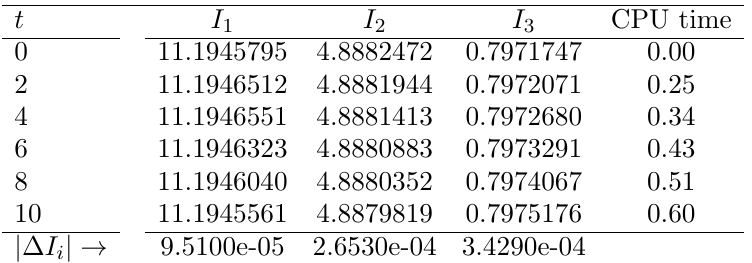
Table 12. Invariants and their changes for p = 3, N = 400 and ∆ t = 0 . 05.